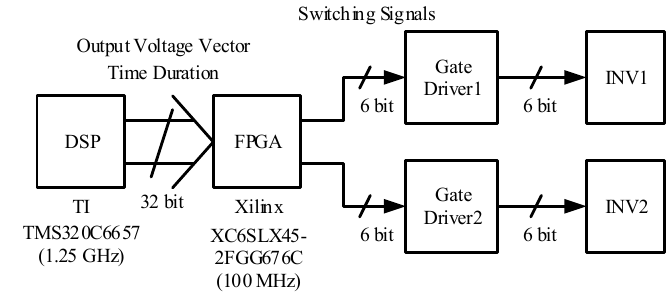
Figure 13. Control block diagram.